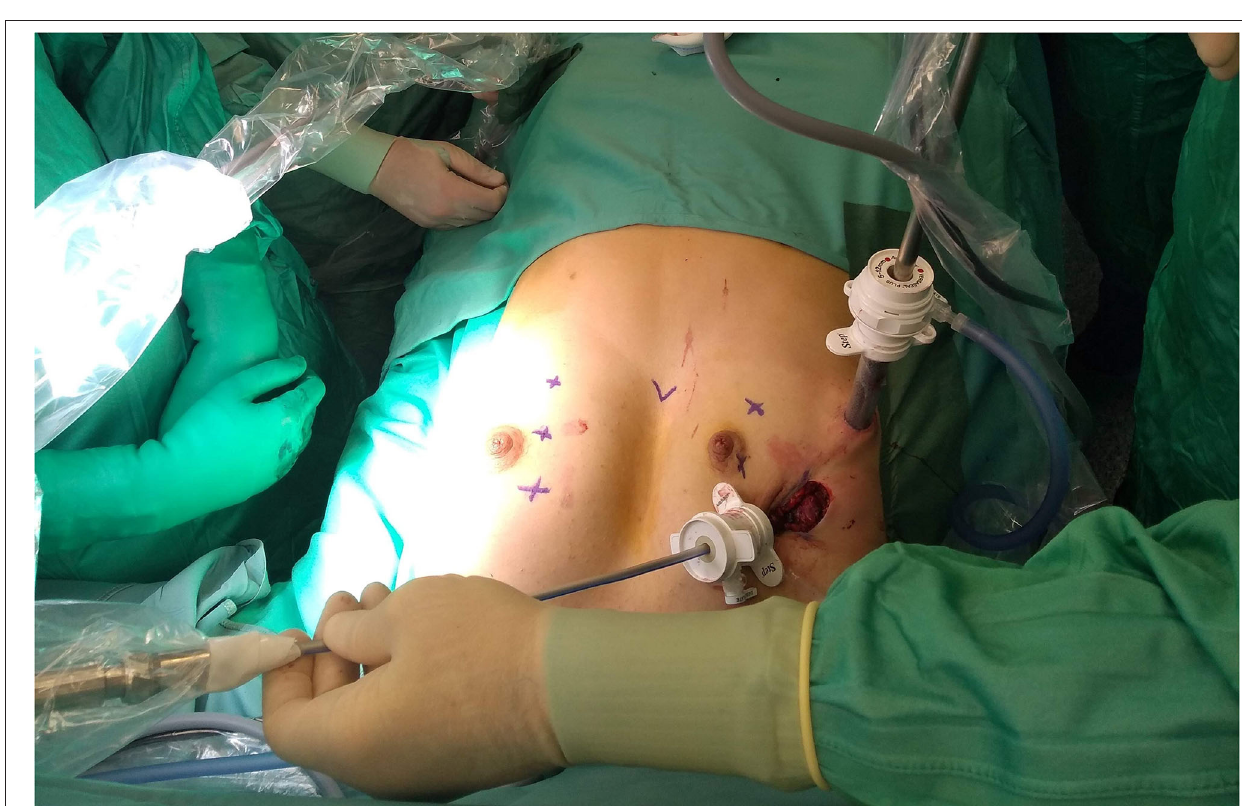
FIGURE 3 | Probe insertion through a 5mm. Trocar placed at the site of surgical incision.